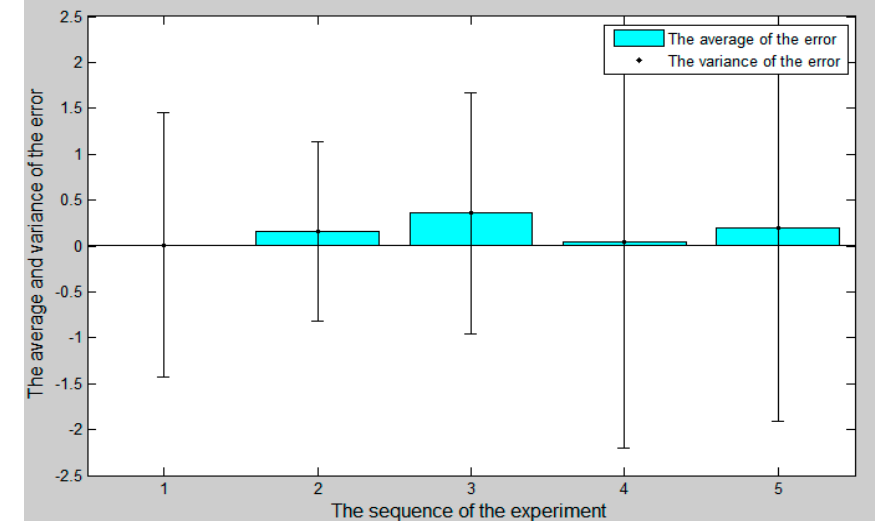
Figure 20. The master–slave radial rotation angle sequence of the experiment